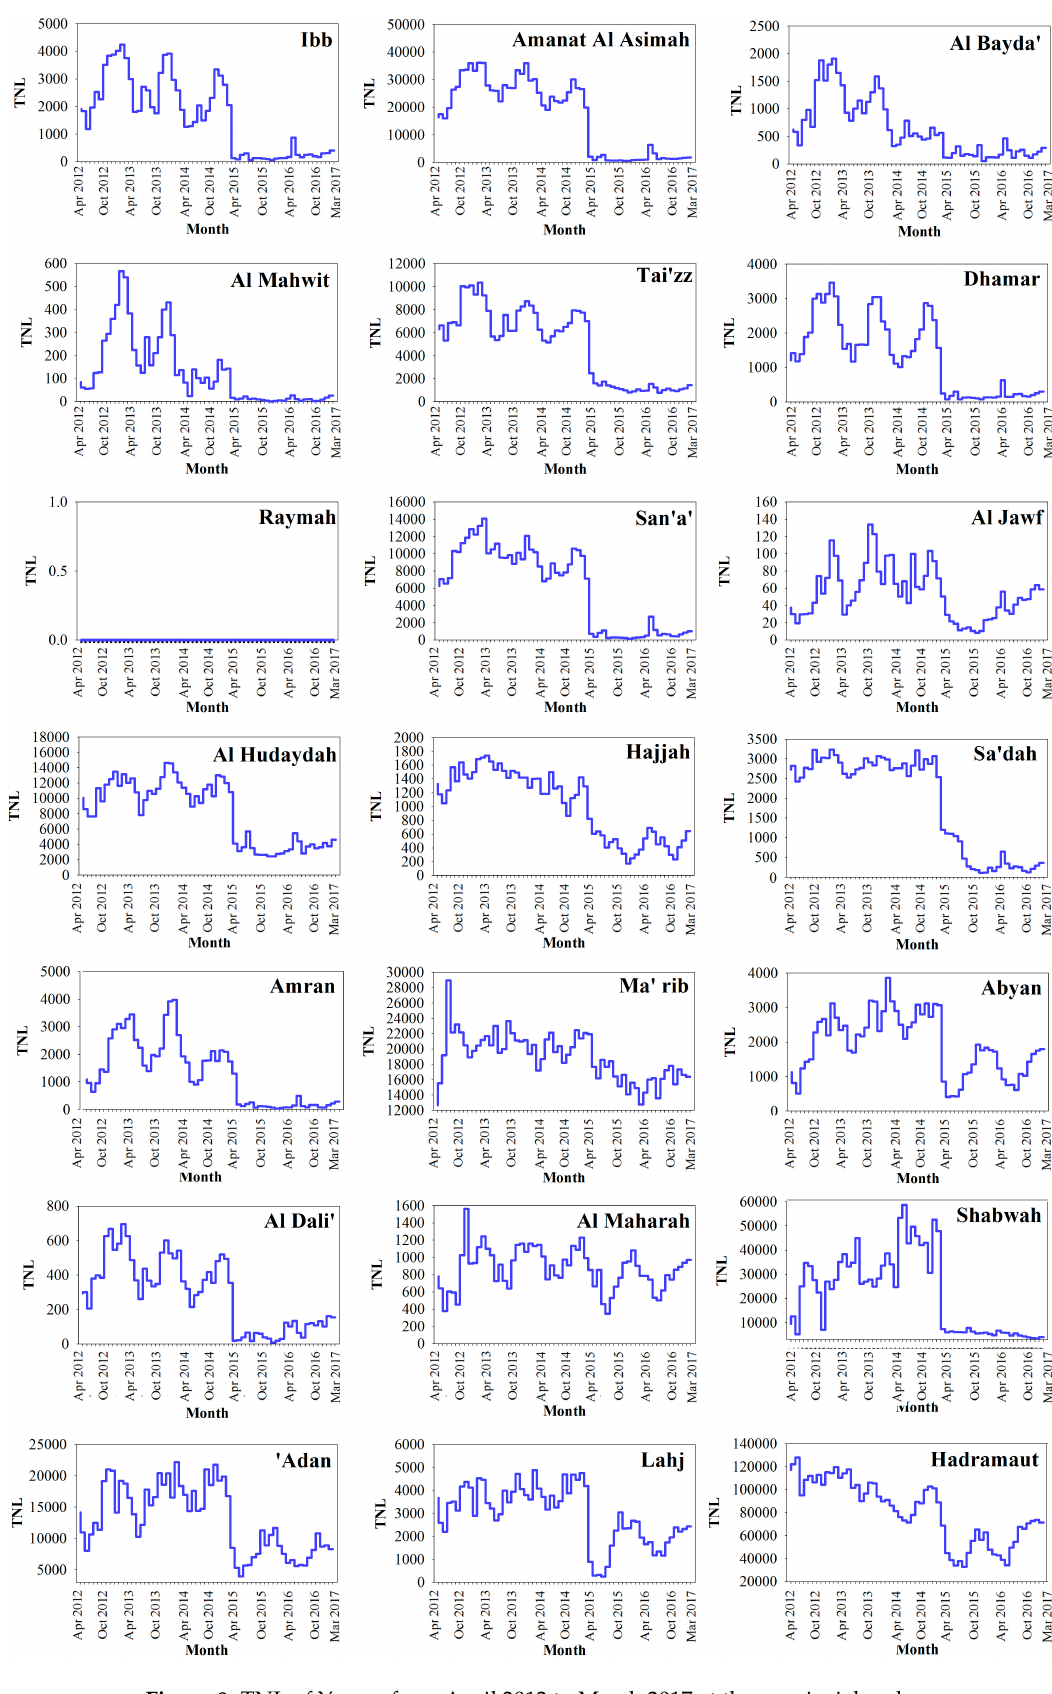
Figure 9. TNL of Yemen from April 2012 to March 2017 at the provincial scale.